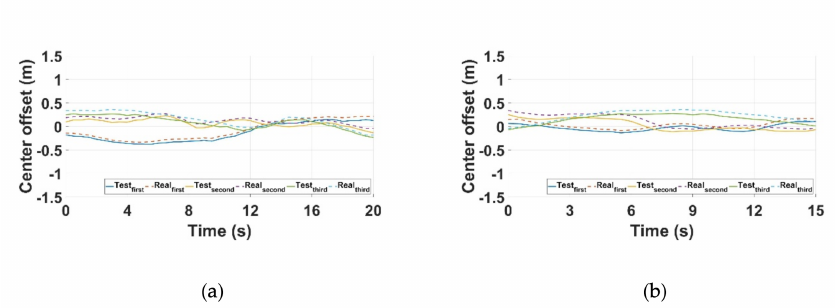
Figure 14. Comparison of theoretical values and real vehicle test results based on distance to the center of the lane ( a ) scenario 6 ( b ) scenario 8.